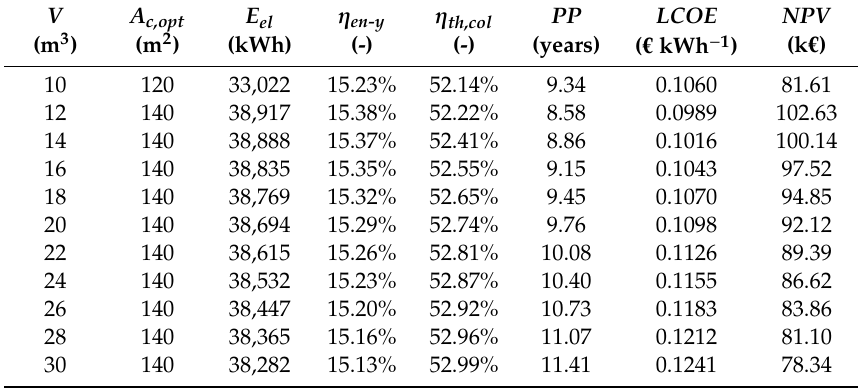
Table 4. Optimum collecting areas for di ff erent storage tank volumes for maximizing energy e ffi ciency.